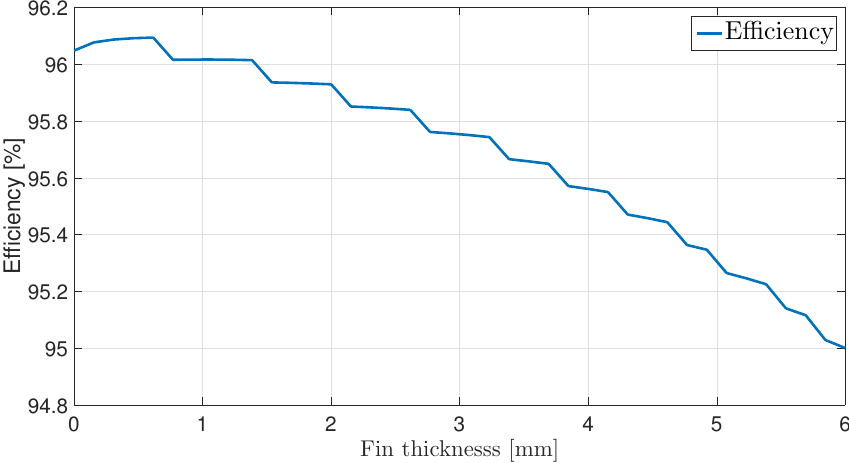
Figure 20. The efficiency variation with the fins